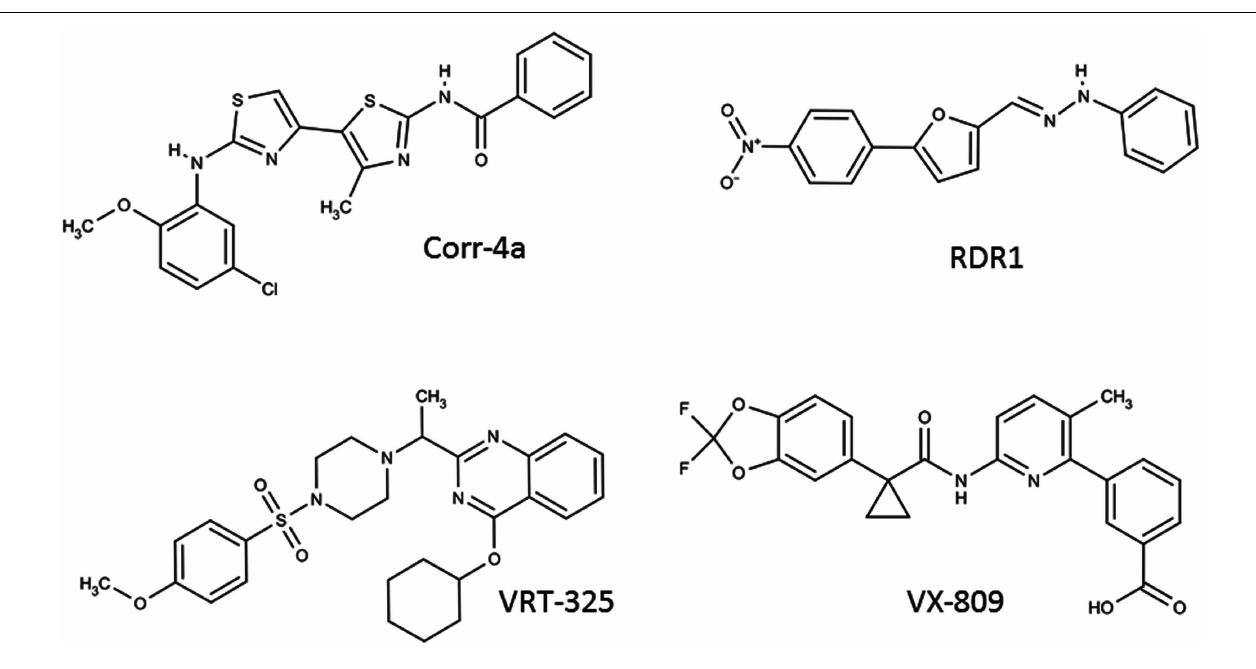
FIGURE 3 | F508del-CFTR corrector